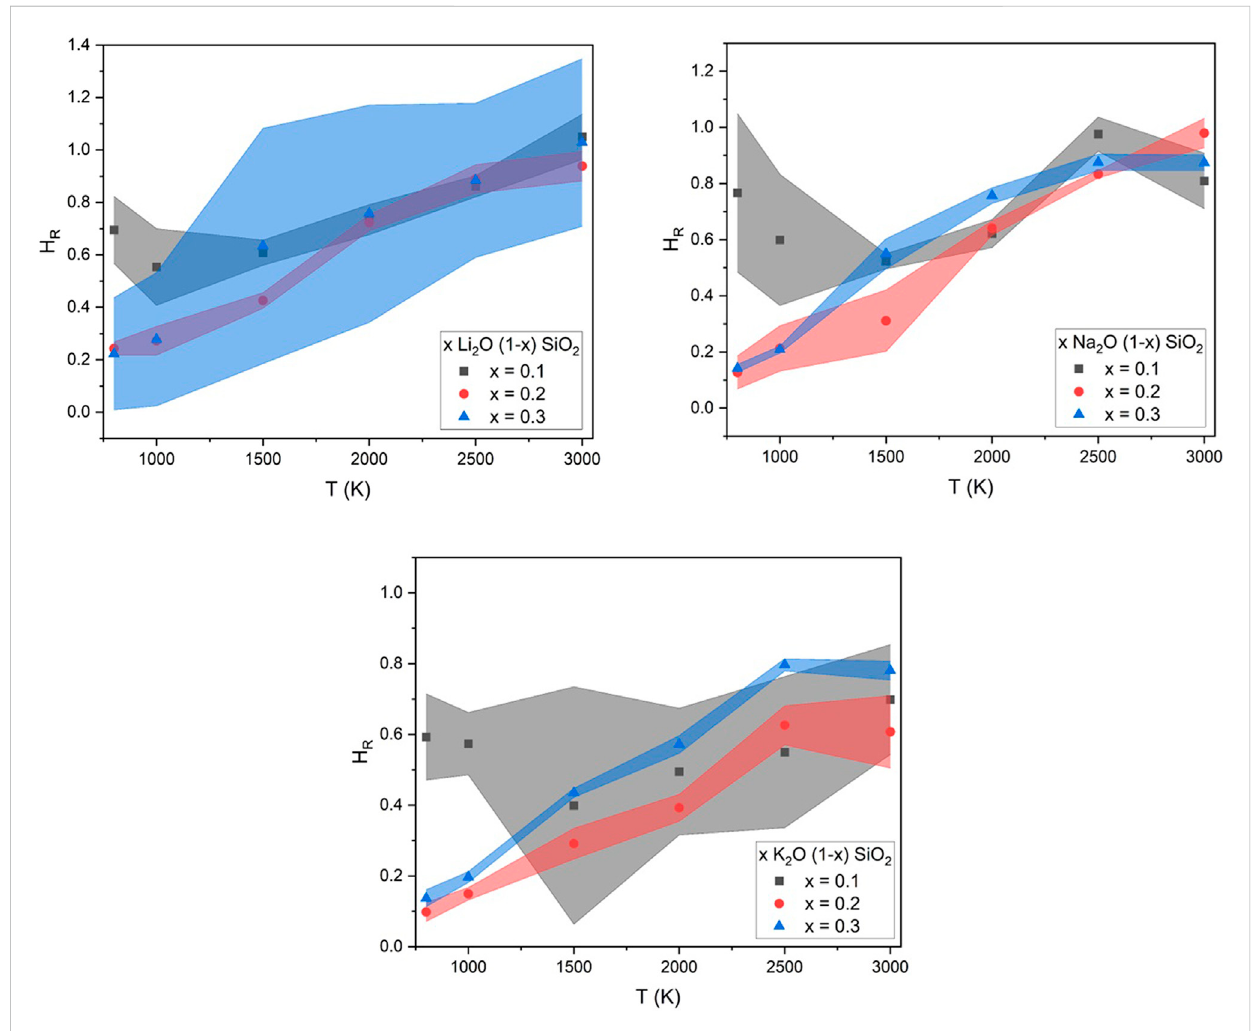
FIGURE 7 Values of Haven ’ s ratio found in this work using MD for the glasses x A 2 O (1-x) SIO 2 , with x = 0.1, 0.2, or 0.3, and A = Li, Na, or K.